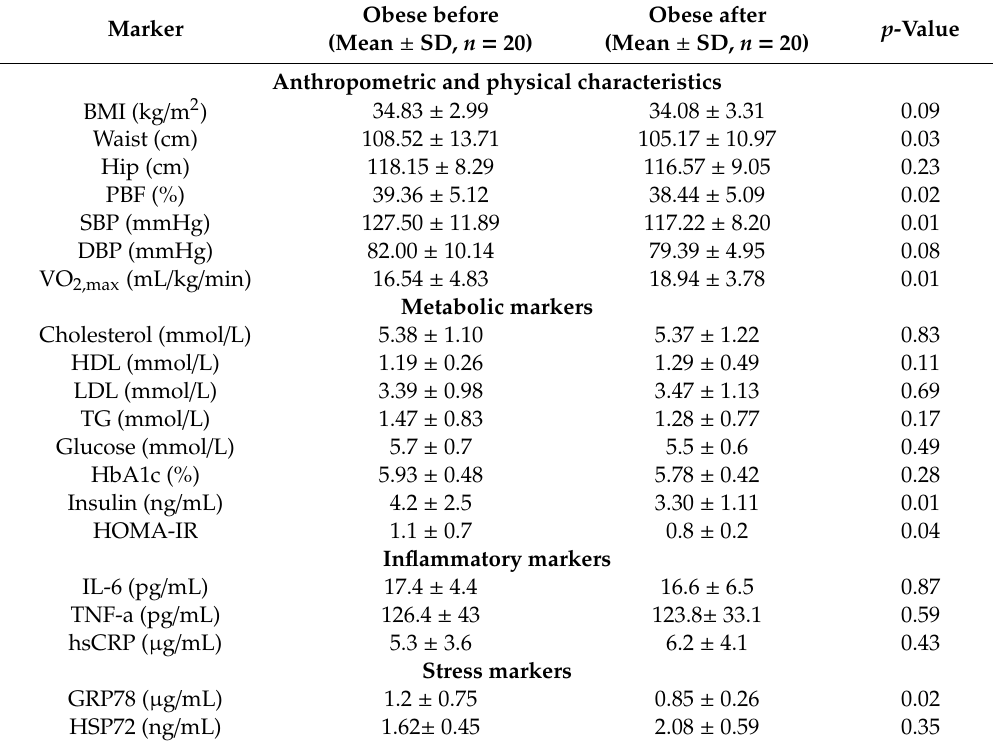
Table 2. Physical, clinical, and biochemical characteristics of obese subjects without diabetes before and after